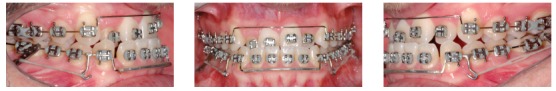
Intraoral photographs at the beginning of mandibular dentition distalization.